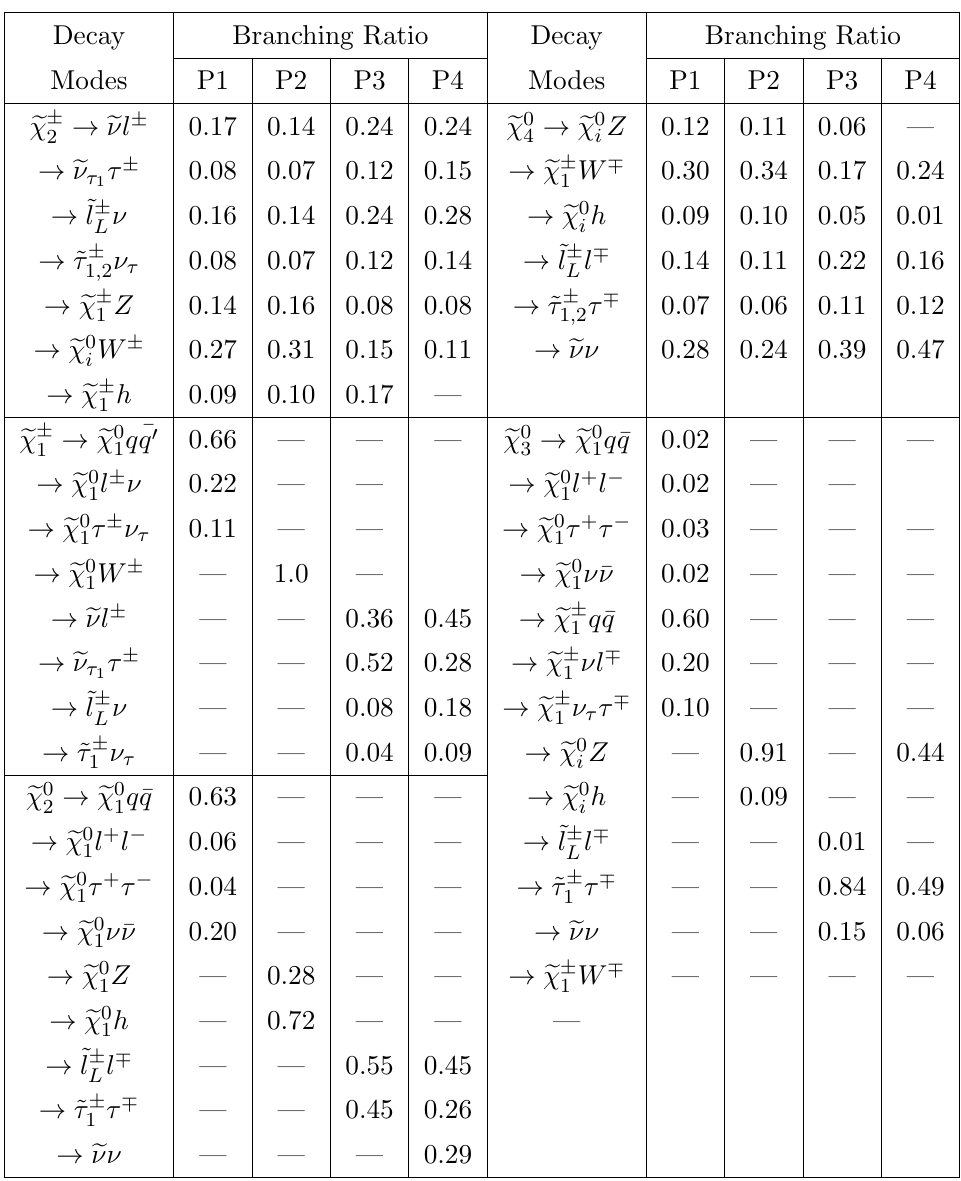
Table 2 . Di(cid:11)erent decay modes of EWeakinos along with their BRs for four representative points as given in table